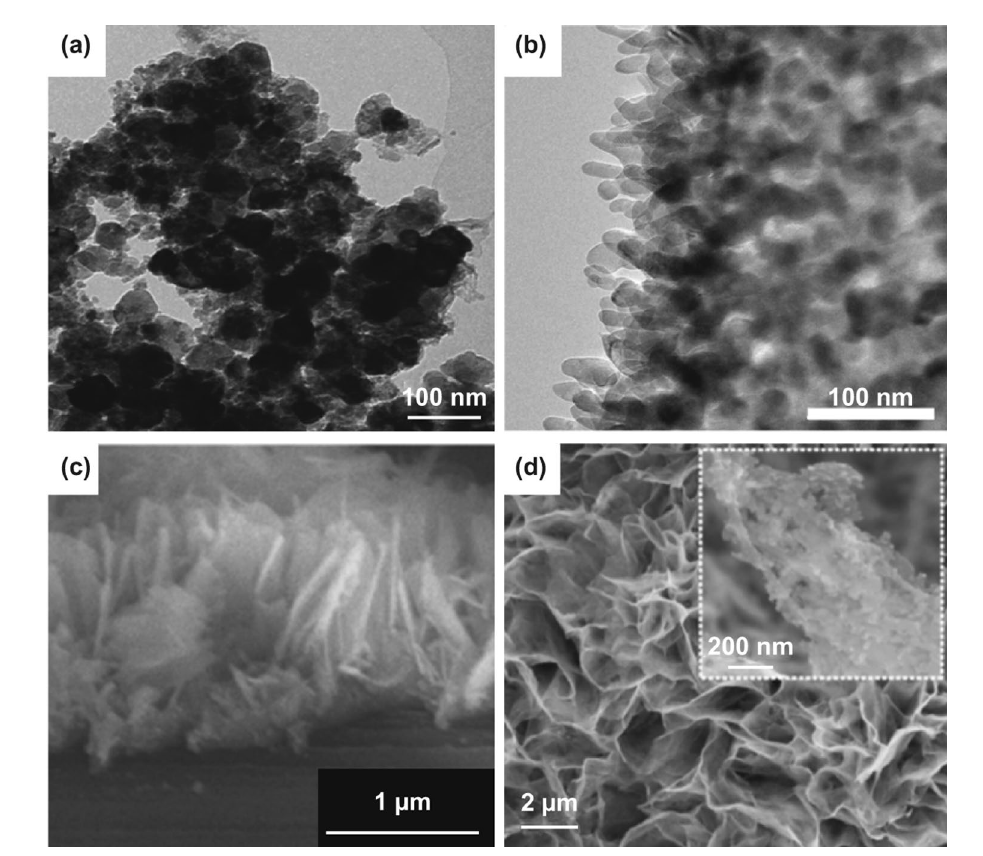
Fig. 25 a , b TEM images of a electrodeposited FeOOH nanoparticles and b Fe 2 O 3 nanorods. c , d SEM images of electrodeposited FeOOH nanosheets and d chemically converted